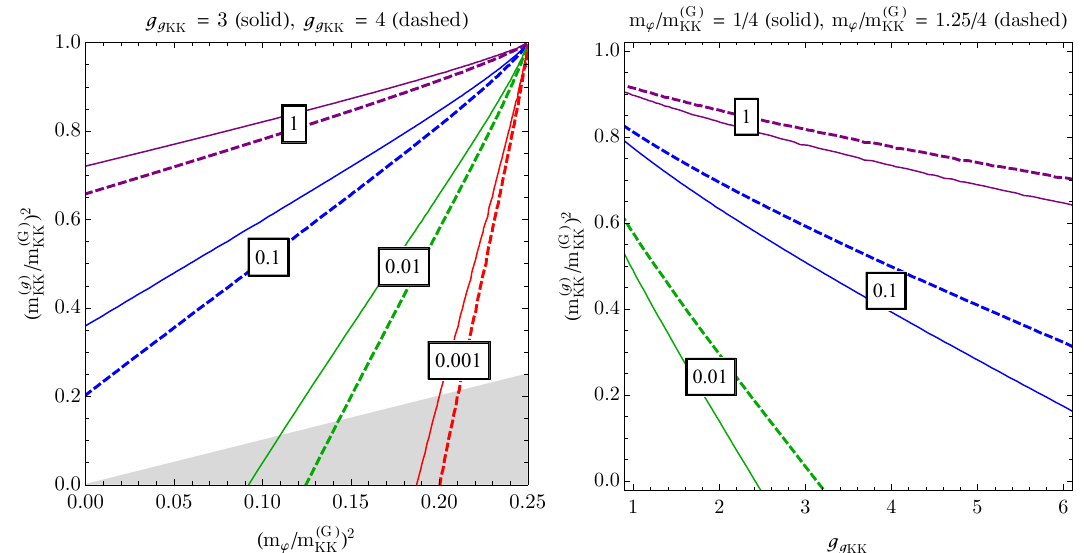
Figure 4 . Left: The BRs of KK graviton to two radions relavitve to that to a KK gluon and a (cid:18)h i 2 h i 2 (cid:19) SM gluon in the m ϕ /m ( G ) , m ( g ) /m ( G ) plane, i.e., each contours is defined by a constant KK KK KK ratios of Γ( G KK → ϕϕ ) to Γ( G KK → g KK g ) . Coupling g g is fixed to two representative values, KK 3 (solid lines) and 4 (dashed lines). In the gray-shaded region, the decay of KK gluon to an on- shell radion and a SM gluon is not kinematically allowed. Right: The corresponding plots in the (cid:18) h i 2 (cid:19) g g , m ( g ) /m ( G ) plane, while m ϕ /m ( G ) is fixed to 1/4 (solid lines) and 1.25/4 (dashed KK KK KK KK